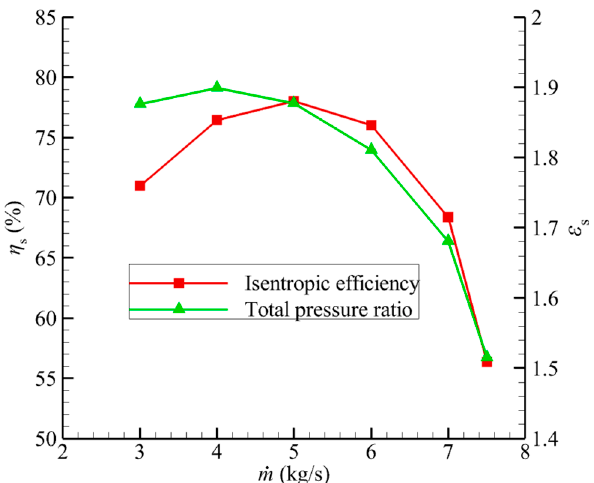
η and total pressure ratio s